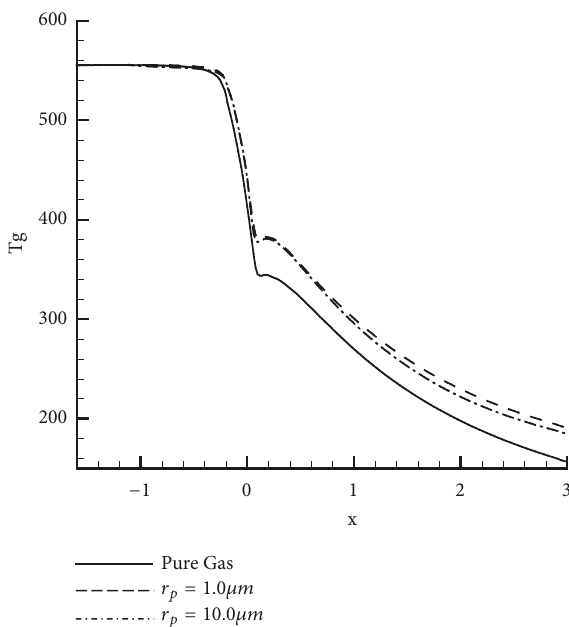
Figure 8: Gas temperature profiles along